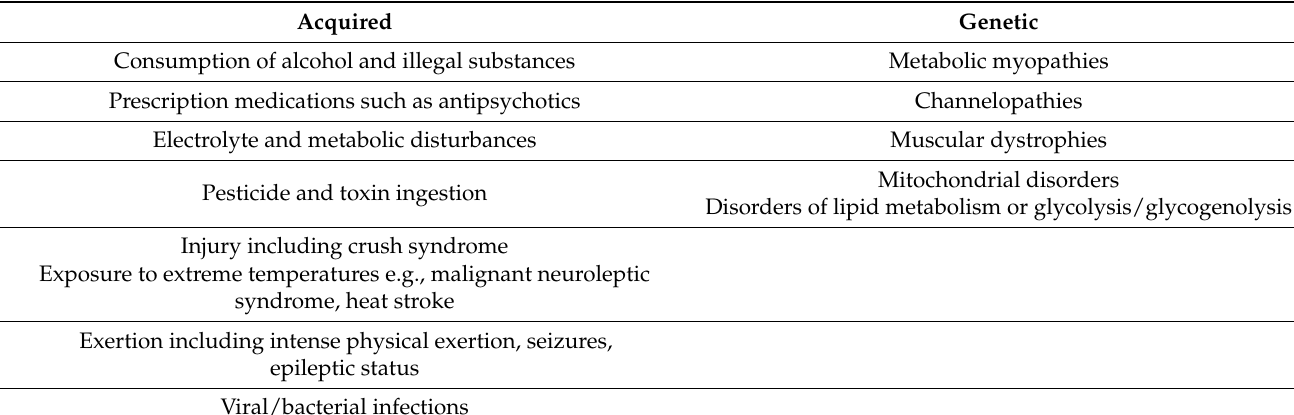
Table 3. Examples of causes of muscle damage